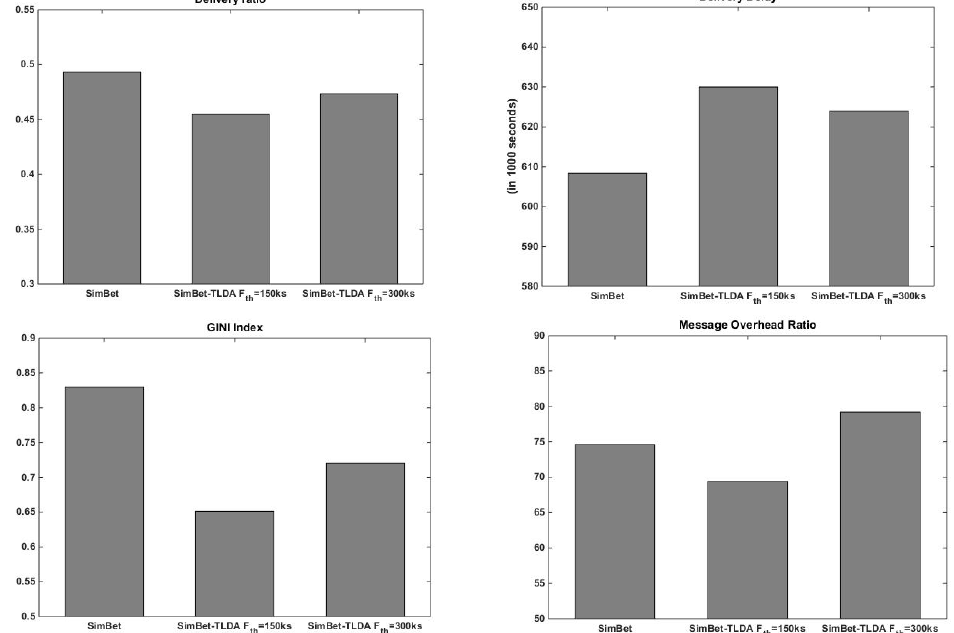
Figure 12. Performance evaluation of SimBet and SimBet-TLDA ( ξ = 0.8) for the Reality mobility scenario. As in the case of BubbleRap, in this case TraLDA is also able to substantially reduce the SimBet’s GINI index, without much affecting other delivery performances.